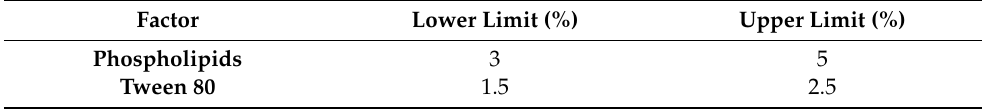
Table 1. Upper and Lower Limit Values in Phospholipids and Tween 80.